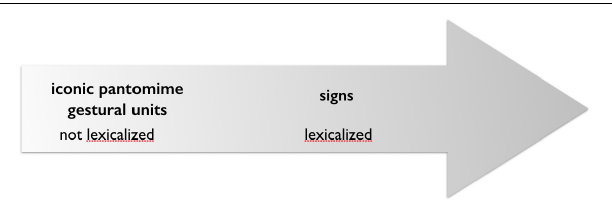
FIGURE 1 | “Lexicalization of gesture”: historical development from gesture to